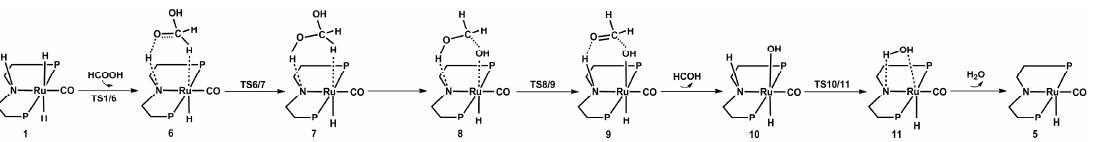
Benzene on P atoms are omitted for clarity.